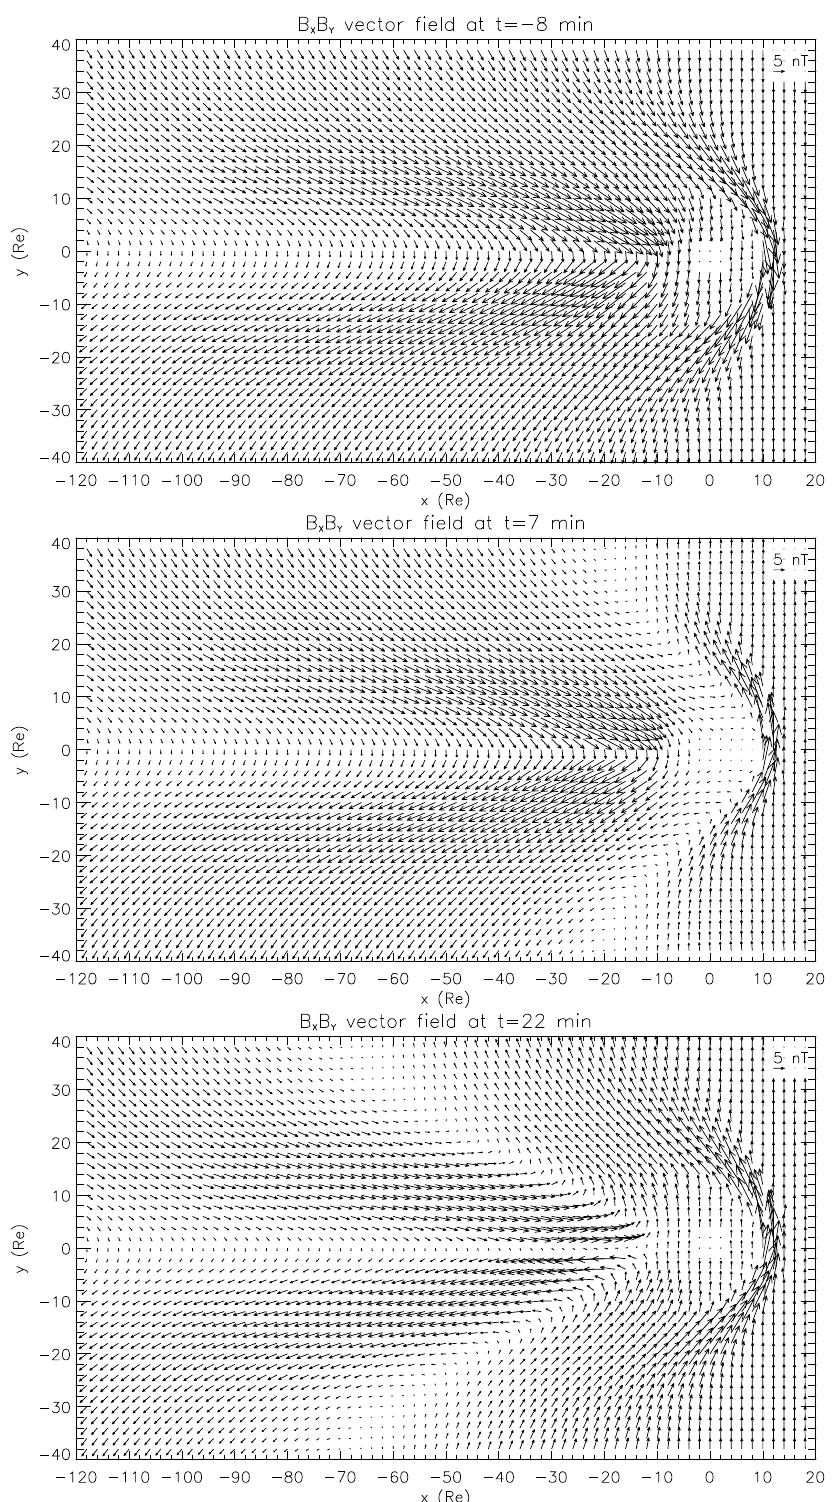
Fig. 5. The magnetic field in the equatorial plane for different points of time during the fast IMF B y sign-change case (run